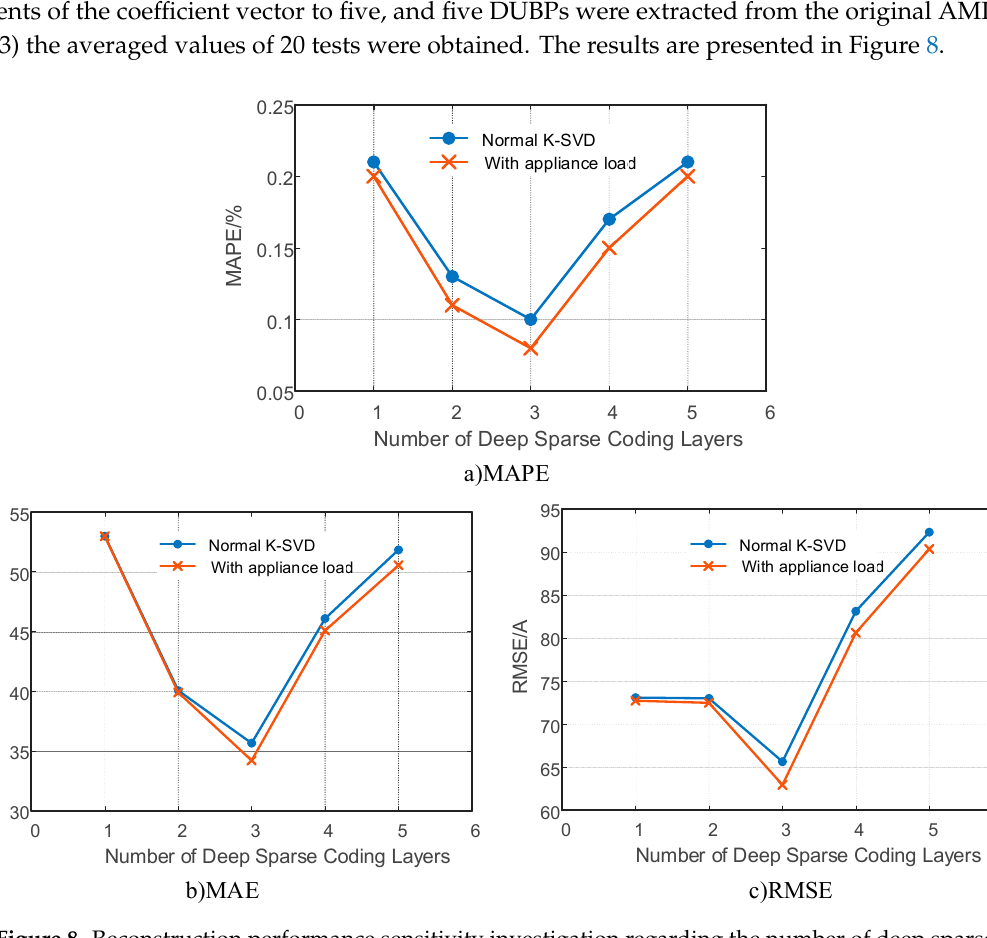
Figure 8. Reconstruction performance sensitivity investigation regarding the number of deep sparse coding layers: ( a ) MAPE, ( b ) MAE, ( c ) RMSE. coding layers: ( a ) MAPE, ( b ) MAE, ( c )